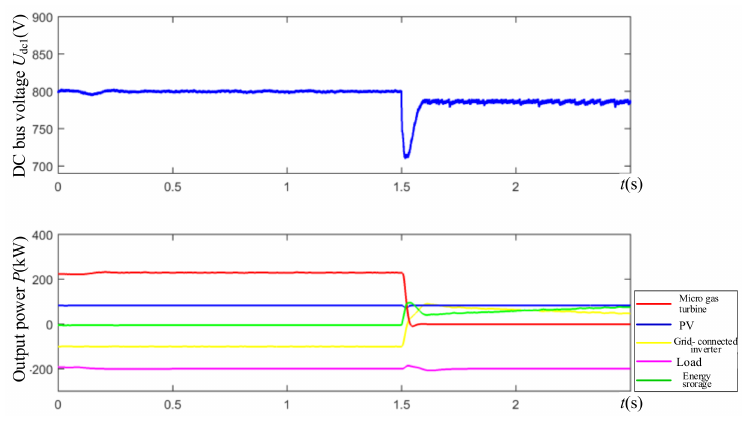
Figure 12. System response when micro-gas turbine is lost.